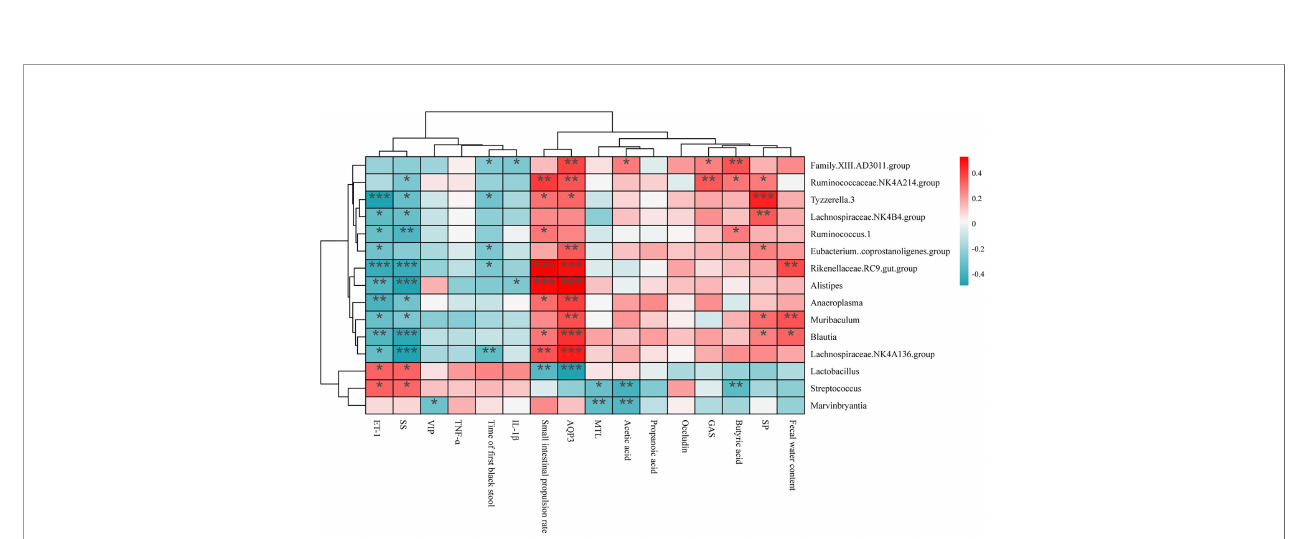
FIGURE 10 | Spearman ’ s correlation analysis between changed bacterial genera and constipation-related indicators. The colors ranged from blue (negative correlation) to red (positive correlation), and signi fi cant correlations were marked by *P < 0.05, **P < 0.01, ***P < 0.001.